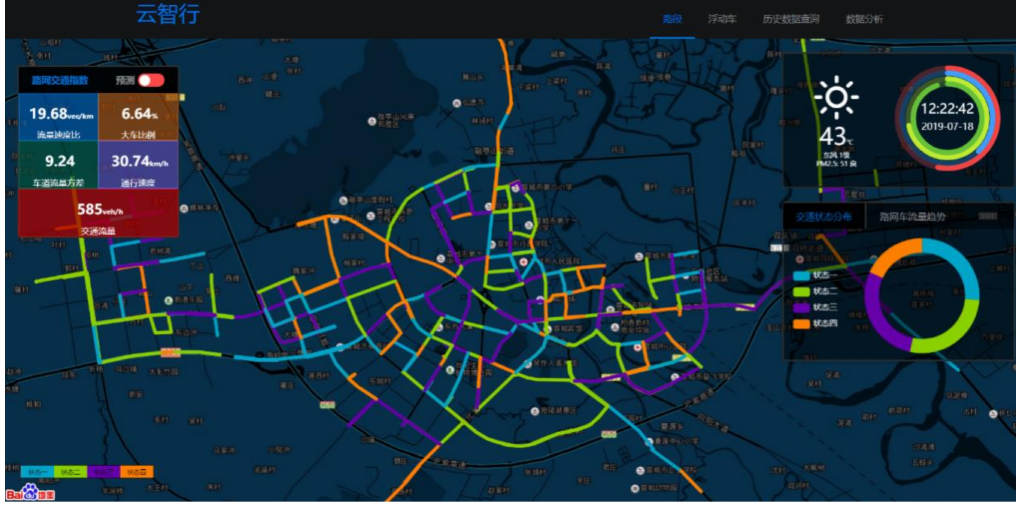
Figure 10. Comprehensive tra ffi c state overview interface of the central city